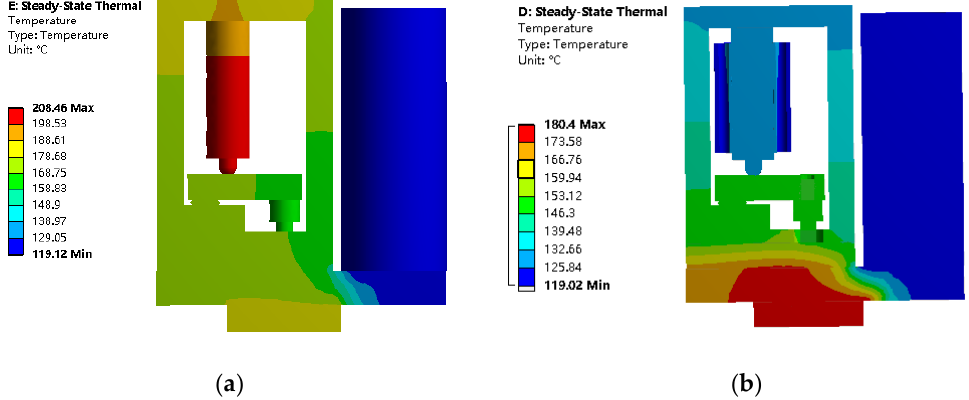
Figure 3. Thermodynamic simulation cloud. ( a ) Operating without cooling mechanism; ( b ) operating with cooling mechanism.